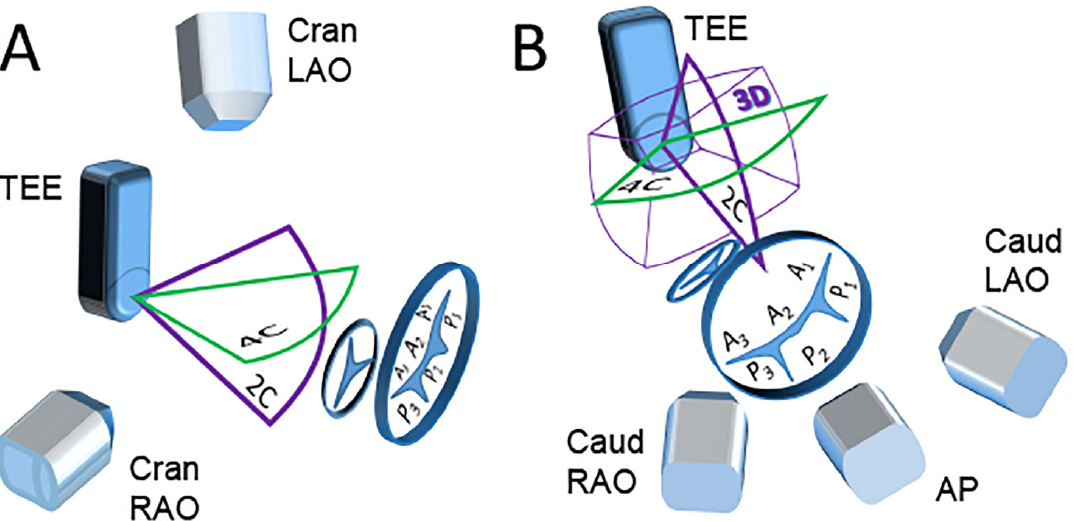
Figure 1. Schematic description of different EFF scenarios. ( A ) “Side view of the TEE probe” sce- nario. ( B ) “Front view of the TEE probe” scenario. The figure presents standard echocardiography planes (green and purple contour) and three-dimensional imaging volume (3D) with X-ray direc- tions depending on different C-arm projections and mitral and aortic annuli with the segmentation of the mitral valve according to Carpentier [12]. 4C and 2C—four- and two-chamber echocardiog- raphy planes, 3D—three-dimensional imaging volume. Positions of the C-arm: Cran—cranial, Caud—caudal, RAO—right anterior oblique, LAO—left anterior oblique, AP—antero-posterior.